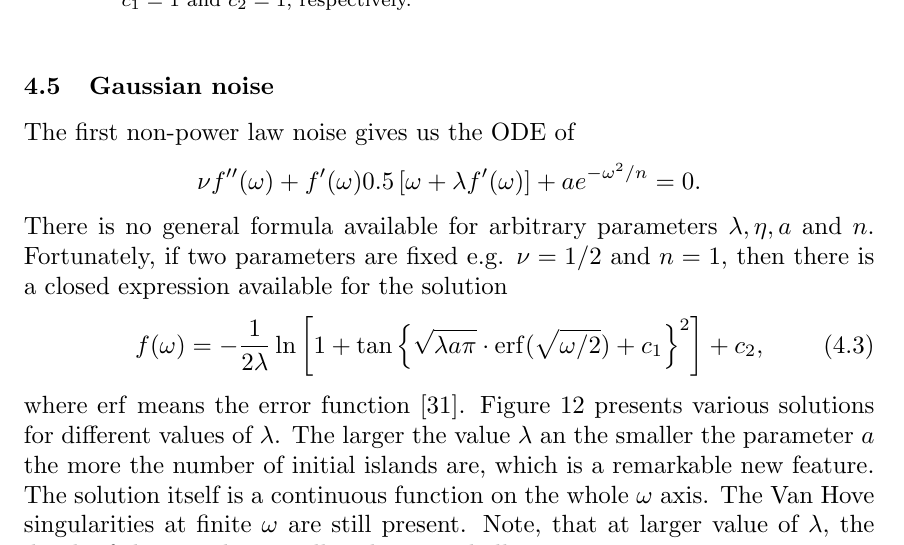
Figure 10. The shape function of the blue noise for the parameter set a = λ = ν = 1 and initial conditions c 1 = 1 and c 2 = 1, respectively.